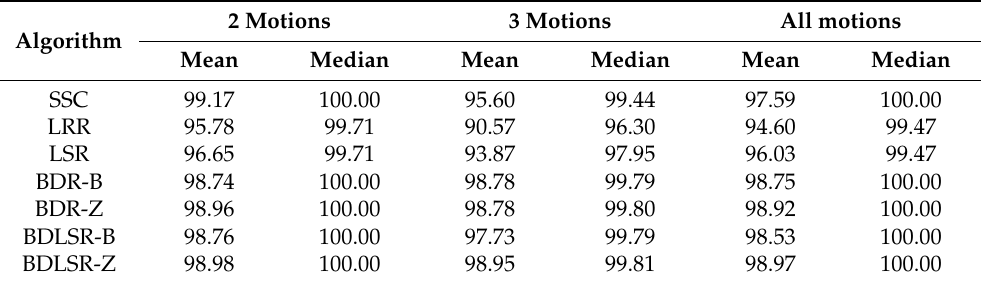
Table 3. The accuracy (%) when using the Hopkins 155 dataset with 4k-dimensional data.